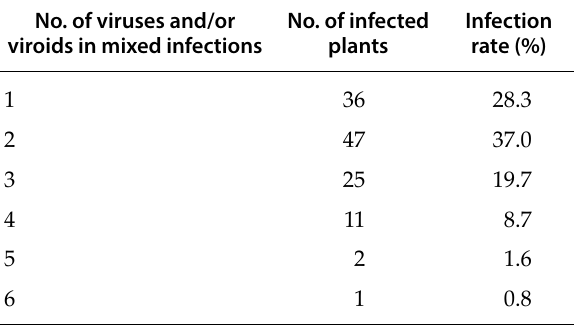
Table 5. Numbers and rates of single and mixed virus and viroid infections detected in grapevines in this study. No. of viruses and/or No. of infected viroids in mixed infections